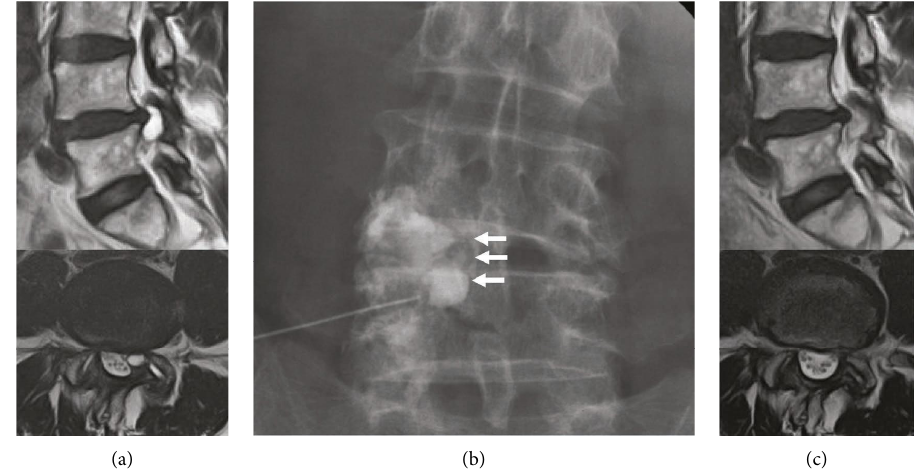
Figure 5: Te case with successful rupture of the cyst: (a) pretreatment MRI, (b) successful rupture of the cyst (arrow: leak of contrast agent), (c) posttreatment MRI. MRI, magnetic resonance